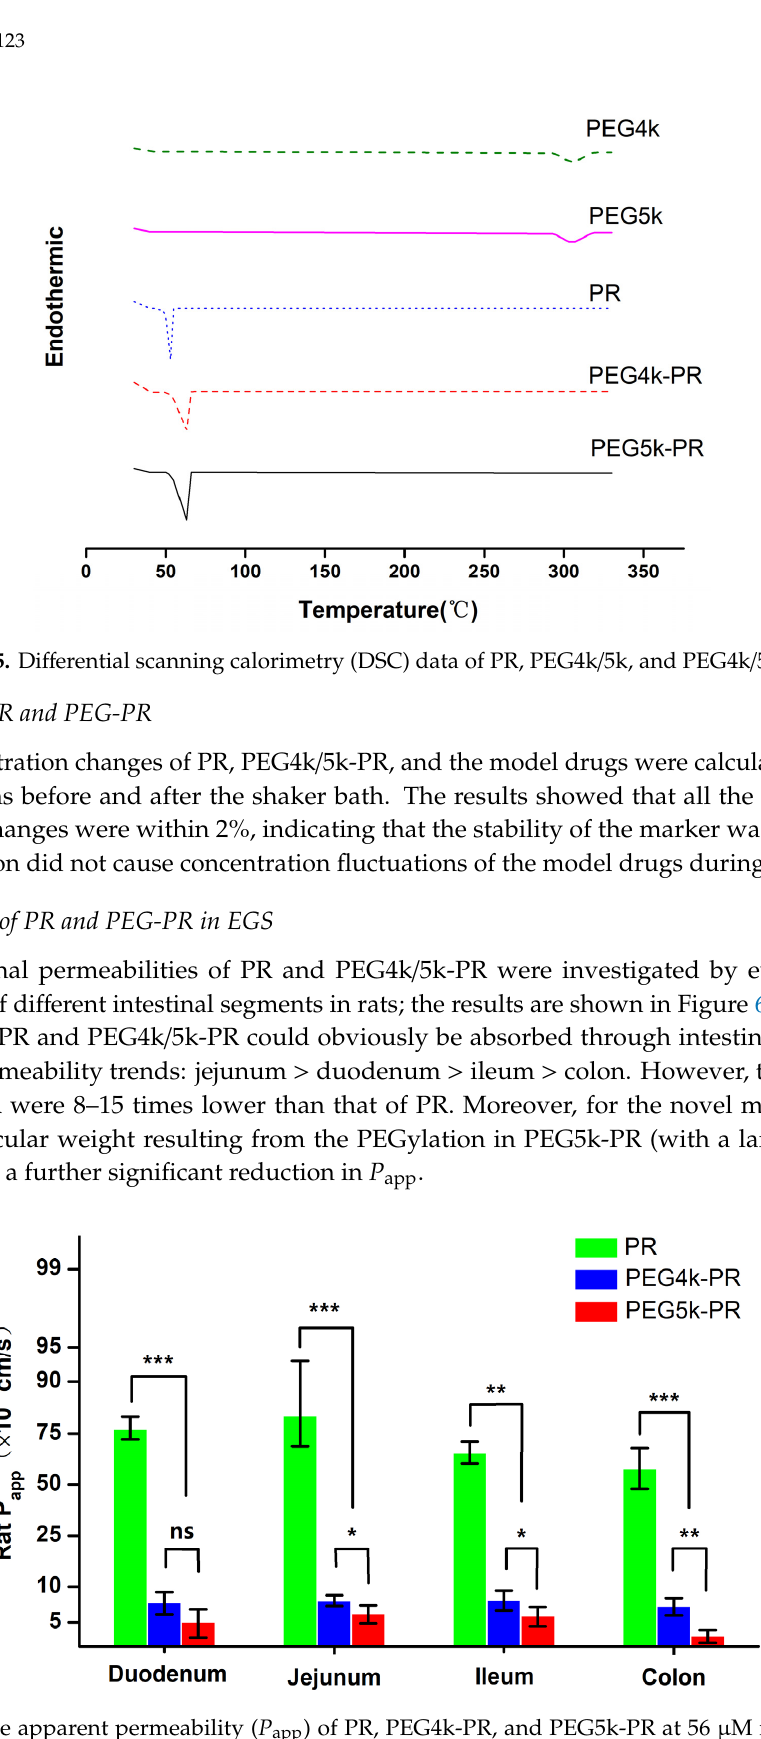
Figure 6. The apparent permeability ( P app ) of PR, PEG4k-PR, and PEG5k-PR at 56 µ M in di ff erent intestinal segments (everted gut sac). Data are shown as mean ± SD, n = 4–6; * p < 0.05, ** p < 0.01 and *** p < 0.001.